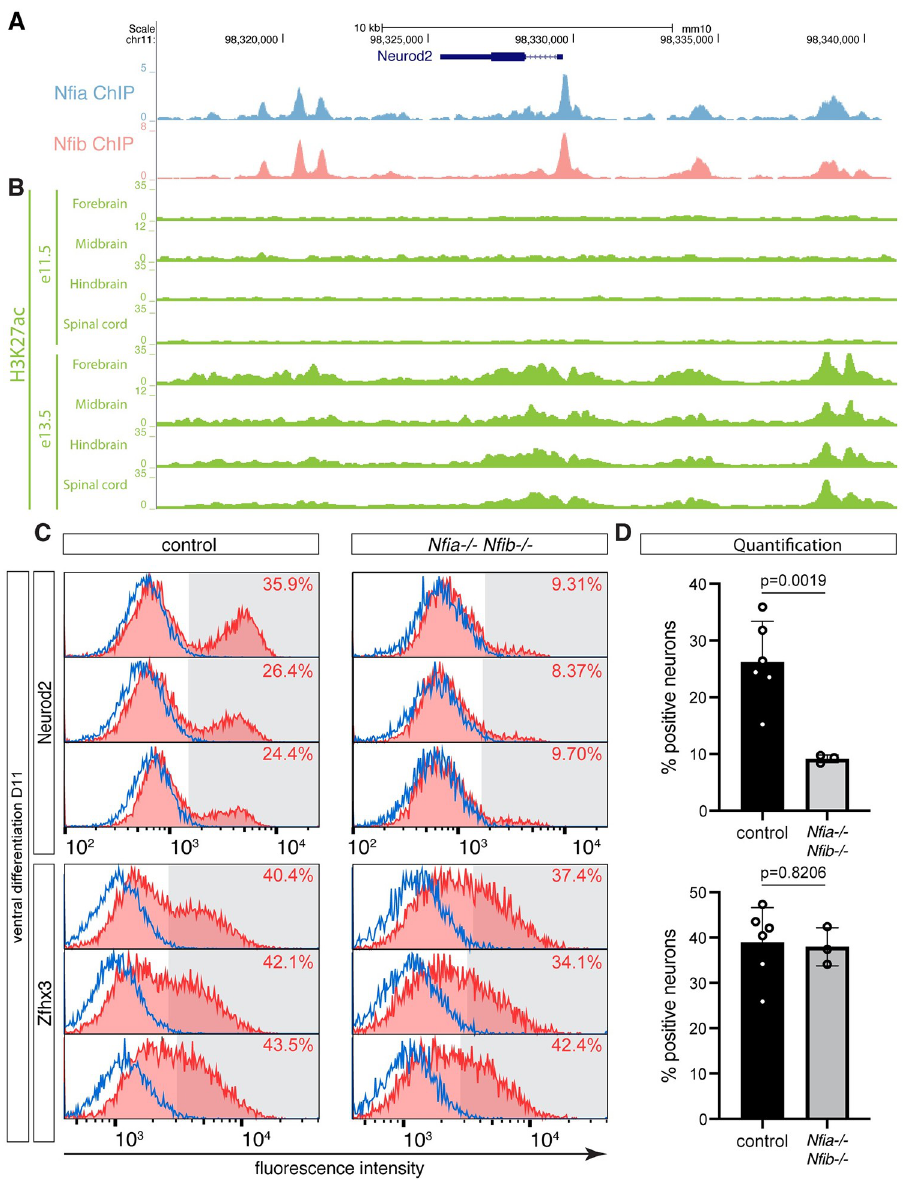
Fig 7. Nfia and Nfib are required for the efficient generation of late-born Neurod2 neurons (see also S14 Fig). (A) Analysis of Nfia and Nfib ChIP-Seq data from the mouse cerebellum [77] confirms binding of Nfia and Nfib to genomic regions in the vicinity of the Neurod2 gene. (B) Analysis of ChIP-seq data from the ENCODE project [78] reveals accumulation of H3K27ac at the same sites between e11.5 and e13.5 in the different regions of the nervous system. (C) Neurod2 (top) and Zfhx3 (bottom) intensity histograms in control (left) and Nfia ; Nfib double mutant (right) neurons (red) and progenitors (blue) at D11 in ventral conditions. Shading indicates the applied thresholds above which cells were counted as Neurod2 or Zfhx3-positive. (D) Percentage of Neurod2 (top) and Zfhx3-positive neurons (bottom) at D11 in control and Nfia ; Nfib double mutants differentiated in ventral conditions ( n = 6 for control and n = 3 for Nfia ; Nfib double mutants). Significance was assessed by unpaired t -test with Welch’s correction. Underlying flow cytometry data are provided in S3 Data. H3K27ac, Histone-3-Lysine-27-acetylation.